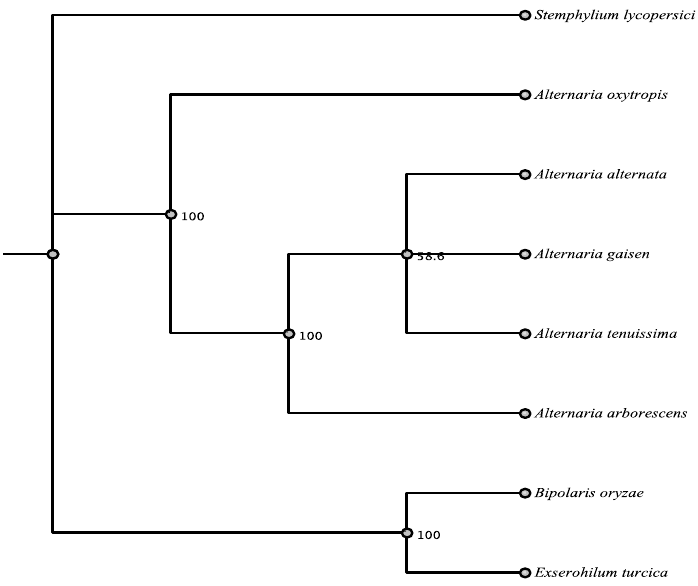
Figure 9. Maximum parsimony tree (MUSCLE alignment and 1000 replicates). Bipolaris oryzae was used as the outgroup. Fungi in tree are pblast results of 33635 sequence. used as the outgroup. Fungi in tree are pblast results of 33635